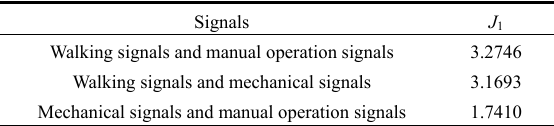
Table 2 Separability criteria.